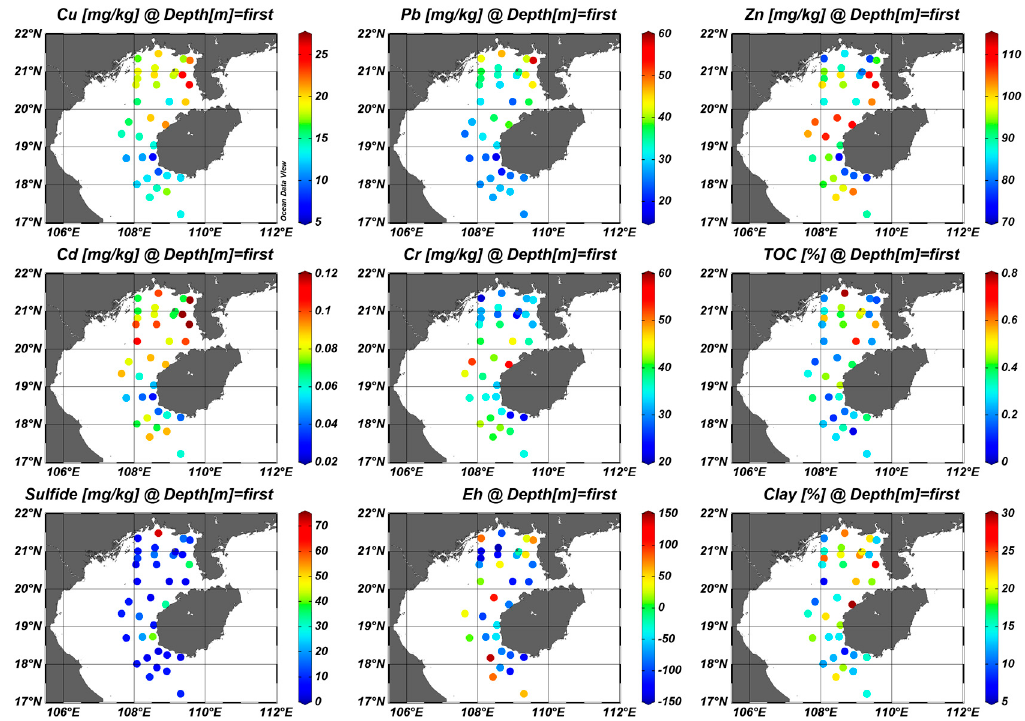
Figure 2. Distribution of heavy metals, total organic carbon (TOC), sulfide, Eh and clay in sediments from the eastern Beibu